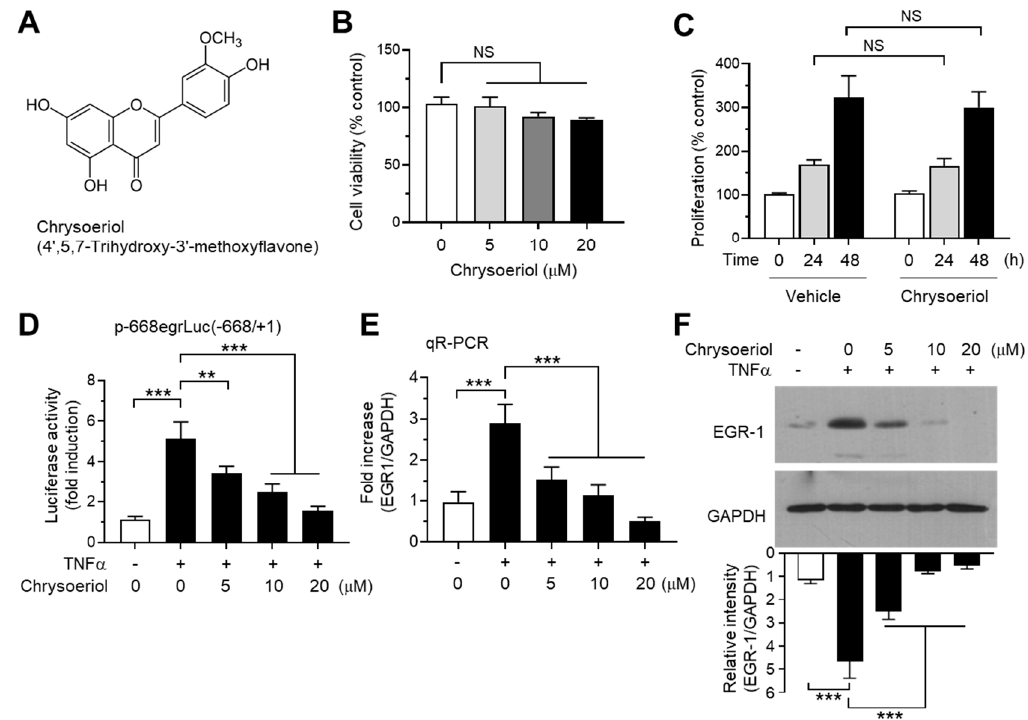
Figure 4. Effect of chrysoeriol on EGR-1 expression. ( A ) Chemical structure of chrysoeriol. ( B ) Cell viability assay. MCF-7 cells were treated with vehicle (DMSO) or increasing concentrations of chrysoeriol (0–20 µ M) for 24 h, and cell viability was determined using the Cell Counting Kit-8 (CCK-8). Graph bars represent the mean ± SD ( n = 3). NS, not significant by Sidak’s multiple comparisons test. ( C ) MCF-7 cells were treated with vehicle (DMSO) or 20 µ M chrysoeriol for different periods (0, 24, and 48 h), and cell proliferation was measured using an ELISA Colorimetric kit for the detection of 5-bromo-2 ′ -deoxyuridine (BrdU) incorporation. Graph bars represent the mean ± SD ( n = 3). NS, not significant by Sidak’s multiple comparisons test. ( D ) MCF-7 cells were transfected with 0.1 µ g of EGR1 promoter–reporter p-668egrLuc(–668 / + 1). After 48 h, the cells were treated with 10 ng / mL TNF α in the presence or absence of chrysoeriol (0, 5, 10, 20 µ M) for an additional 8 h, and the luciferase reporter activities were measured. ( E , F ) MCF-7 cells were pretreated with chrysoeriol (0, 5, 10, and 20 µ M) for 30 min, followed by treatment with 10 ng / mL TNF α . After 1 h, cells were harvested and the EGR1 mRNA levels or protein levels were measured by qR-PCR ( E ) or immunoblot analysis ( F ), respectively. Band intensities were measured using the ImageJ software. Bars represent the mean ± SD ( n = 3). ** p < 0.01, *** p < 0.001 by Dunnett’s multiple comparisons test. qR-PCR, quantitative real-time PCR.